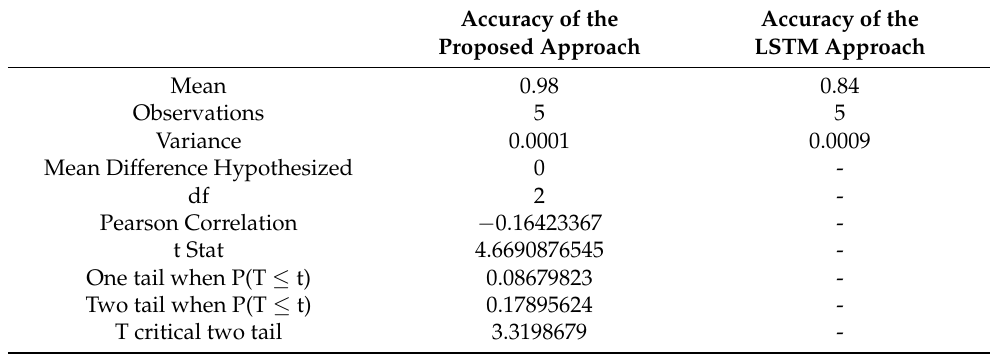
Table 8. Paired t -test for significant